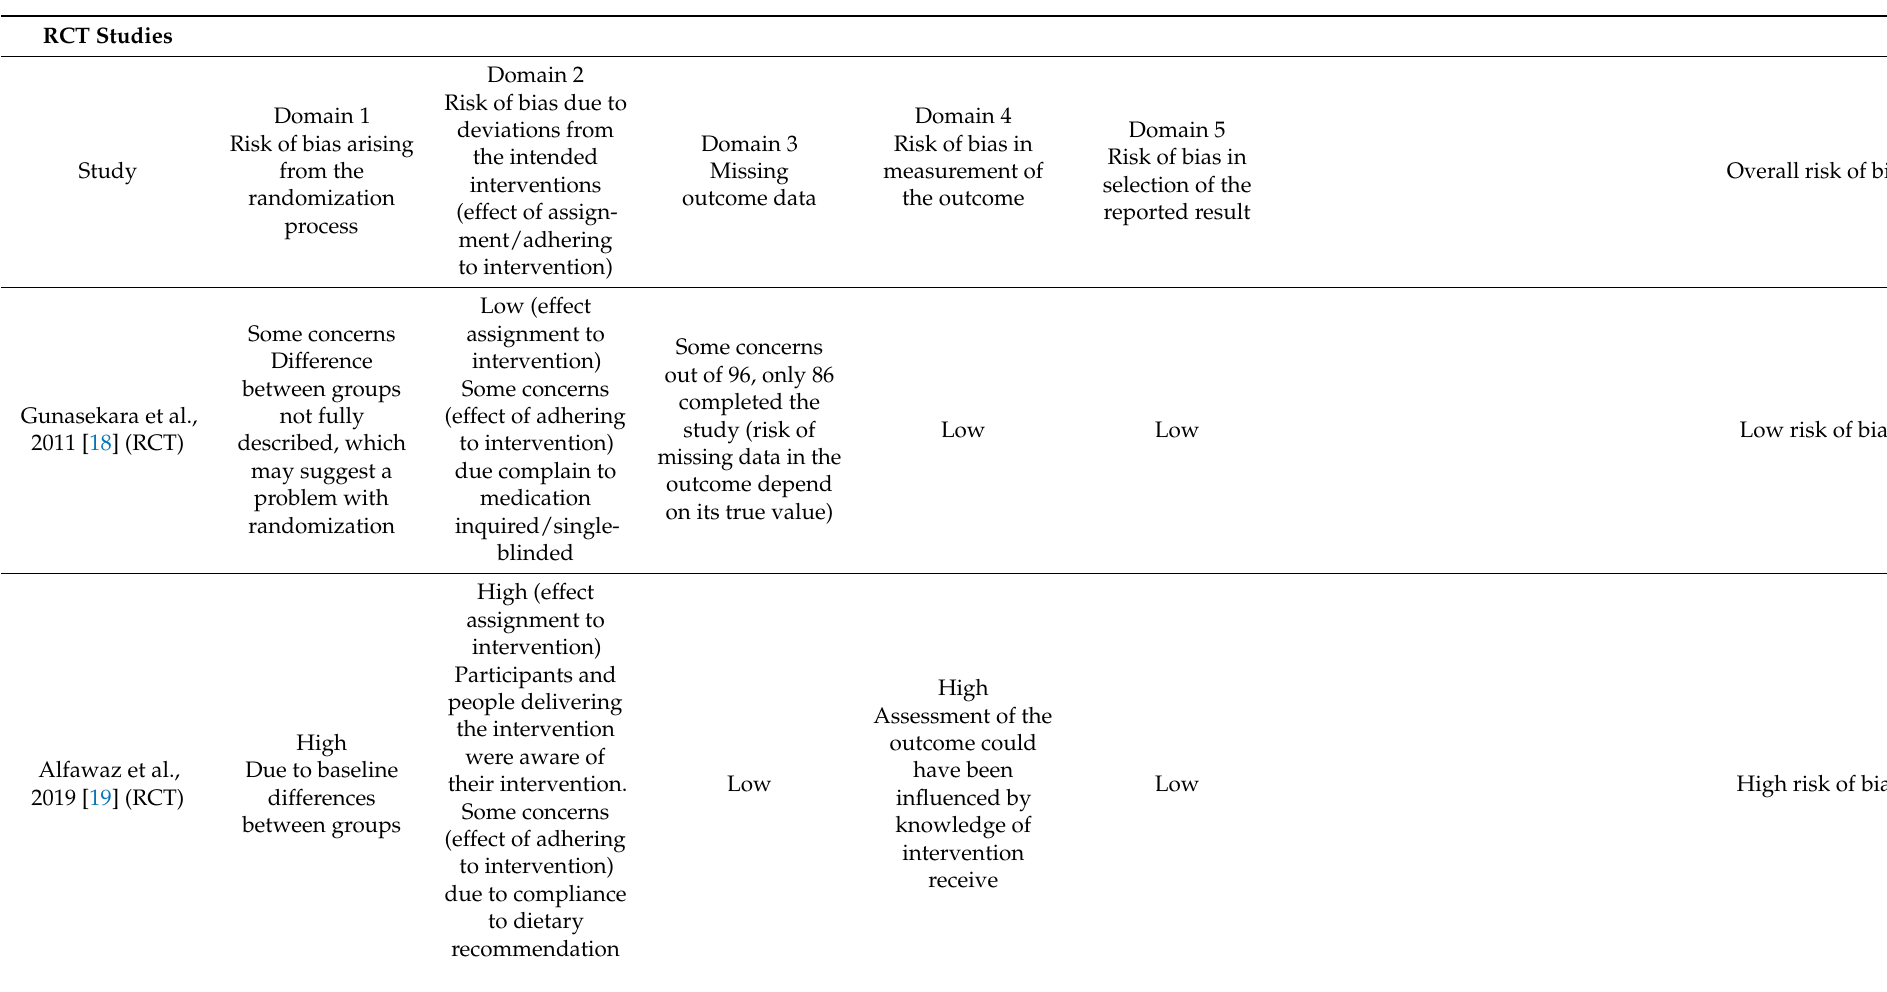
Table 4. Summary of the quality assessment of studies using Cochrane risk-of-bias tool for